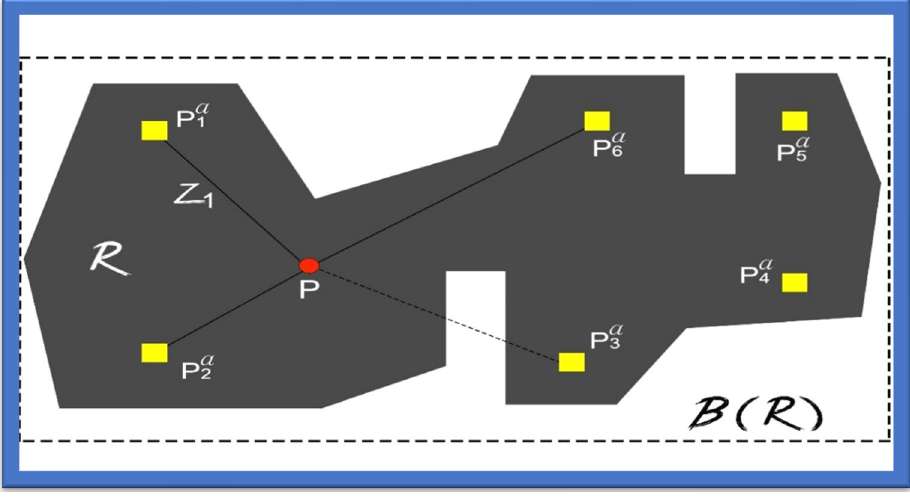
Figure 3. Navigation Using Wi-Fi Triangulation.